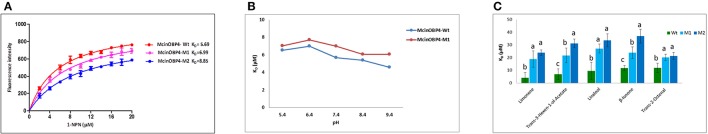
Binding Affinities of 1-NPN and corn odorants to McinOBP4 mutants. (A) Affinities of 1-NPN to the McinOBP4-Wt and two mutants. Dissociation constants (KD) were 5.69 ± 0.83 μM for McinOBP4-Wt, 6.99 ± 0.59 μM for McinOBP4-M1, 8.85 ± 0.63 μM for McinOBP4-M2 are shown in inset. (B) The dissociation constants of the complexes with 1-NPN of McinOBP4-Wt and C-truncated mutant McinOBP4-M1 at different pH level. At neutral basic pH level, both proteins showed a maximum activity. (C) Dissociation constants of complexes between McinOBP4-Wt and its two mutants (McinOBP4-M1 and M2) and the five selected odorants. These two mutants showed lower binding affinity to selected corn odorants with respect to the wild type, indicating that the respective amino acid is involved in binding these corn odorants.